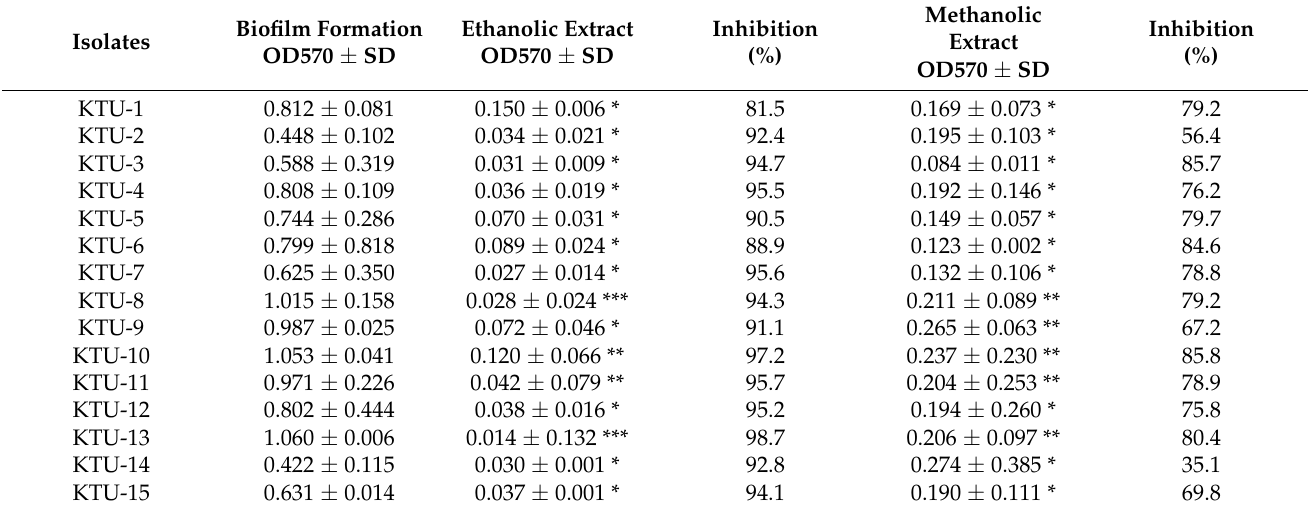
Table 7. Antibiofilm potentialities of ethanolic and methanolic Rhazya stricta leaf extracts against Klebsiella